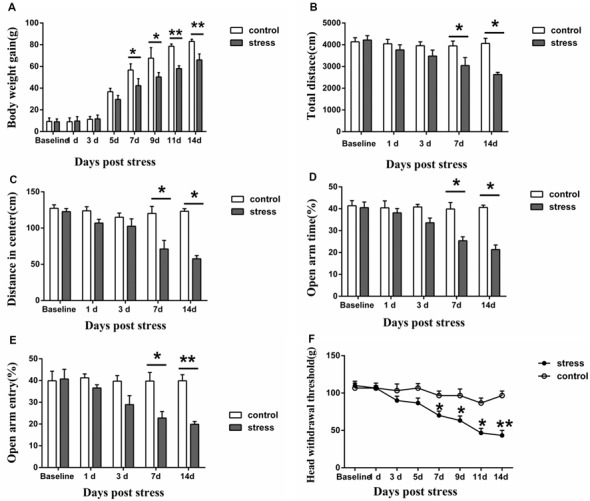
Effect of chronic restraint stress on body weight gain (A), behavior (B–E) and the head withdrawal threshold (F) in rats. In the open field test, the total distance traveled (B) and the distance traveled in the center (C) were measured, and in the elevated plus-maze test, the percentage of open-arm entries (D) and the open-arm retention time (E) were measured. All data were calculated as the mean ± SD (n = 8/group). *P < 0.05, **P < 0.01 vs. the matched control group.